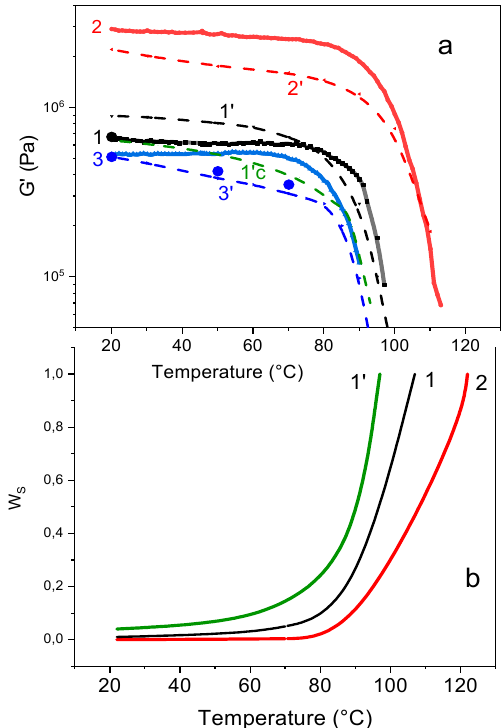
Figure 10. Storage modulus ( a ) and sol fraction ( b ) of the DA networks as a function of temperature. a) Curves: 1—F4D2000–PPO3BMI; 2—4D2000-HBMI; and 3—F4D2000–PPO30BMI. Rate of heating 2 °C/min. Dash curves 1‘, 2‘, and 3‘—corresponding theoretical moduli; 1’c—4 % cyclization included. Points—experimental equilibrium values. (b) #heoretical curves, 1,1‘- F4D2000–PPO3BMI, without cyclization and with 6 % cyclization, respectively, and 2—F4D2000-HBMI,